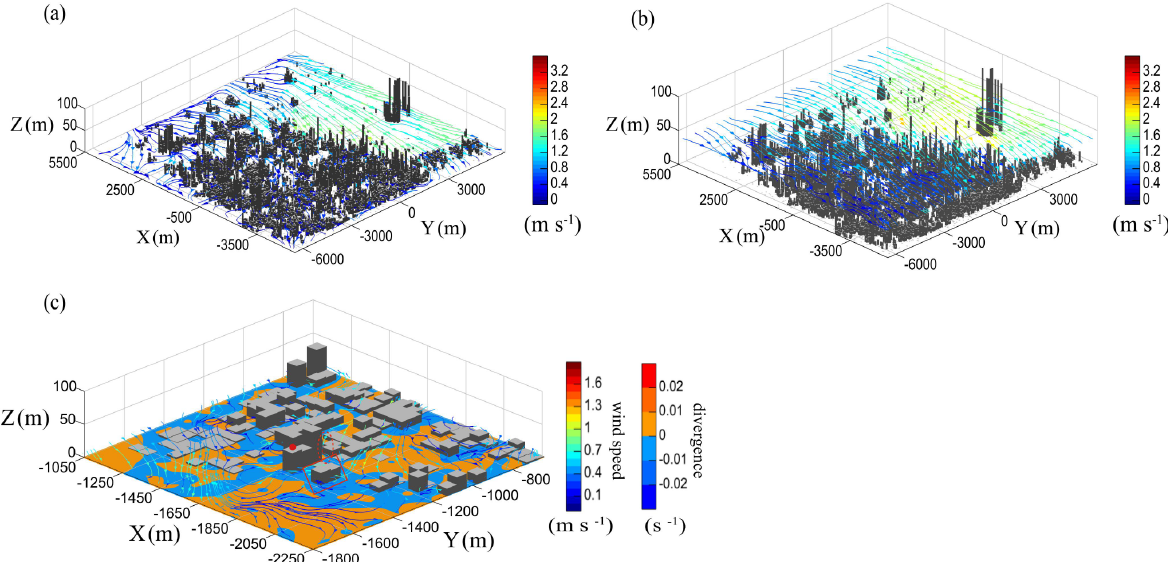
Figure 5. The simulated wind streamlines at the height of 5 (a) and 40m (b) averaged in January 2019 in the whole S-TRACK simulation domain; the simulated wind streamlines and divergence (c) at the near surface averaged in January 2019 in the sub-domain A (see in Fig. 3a). The BSC monitoring site is marked with red